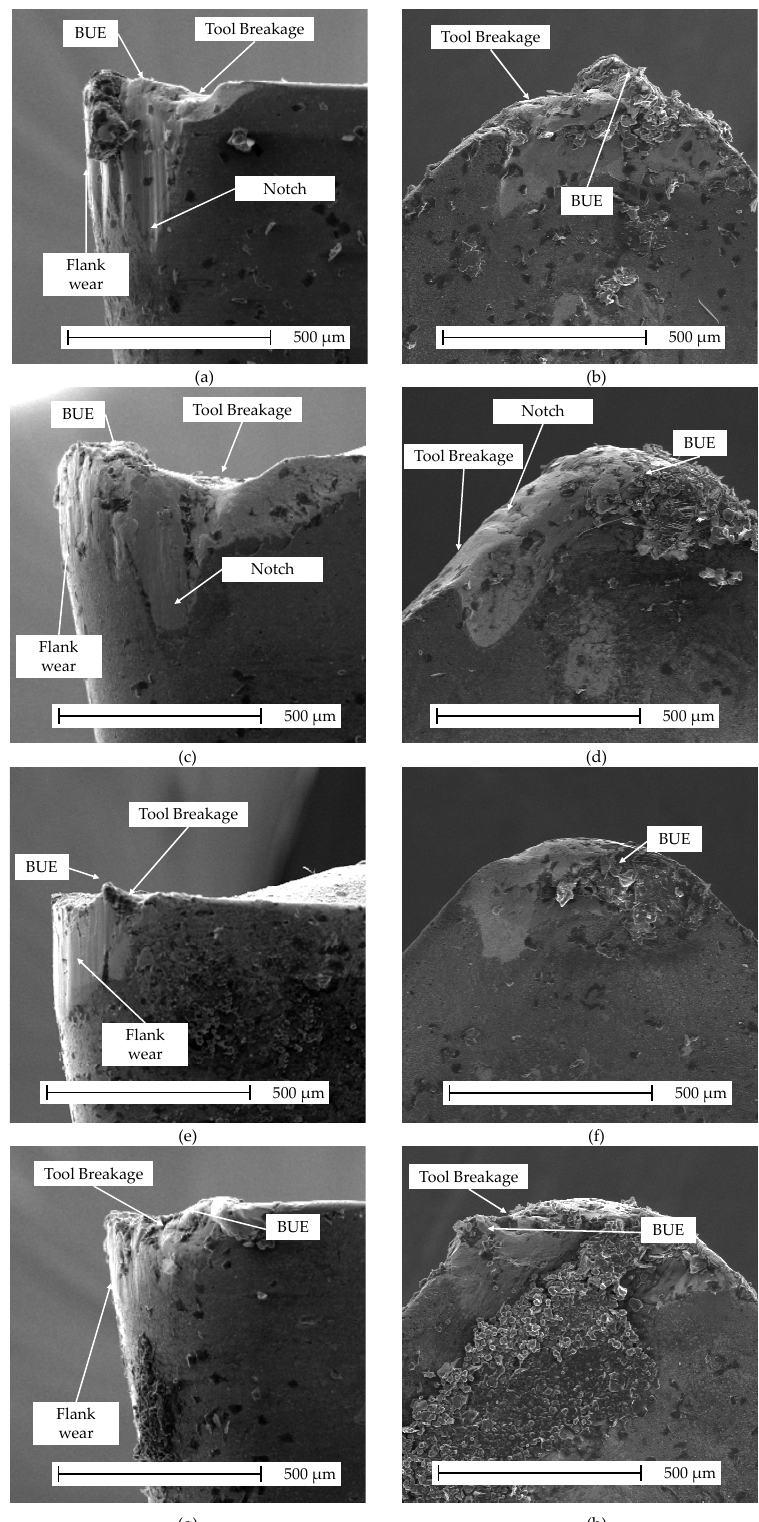
Figure 7. SEM images at the end of the tool life for different cutting conditions in Haynes 282 turning tests with high pressure cooling. For 50 m/min and 0.1 mm/rev: ( a ) relief surface and ( b ) rake surface view. For 50 m/min and 0.15 mm/rev: ( c ) relief surface and ( d ) rake surface view. For 90 m/min and 0.1 mm/rev: ( e ) relief surface and ( f ) rake surface view. For 90 m/min and 0.15 mm/rev: ( g ) relief surface and ( h ) rake surface